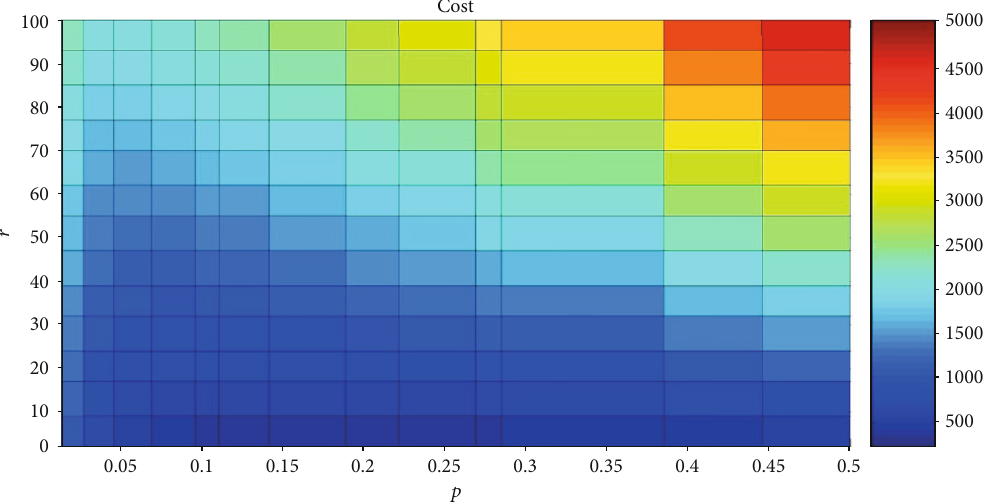
Figure 2: The relationship between cost and p and r